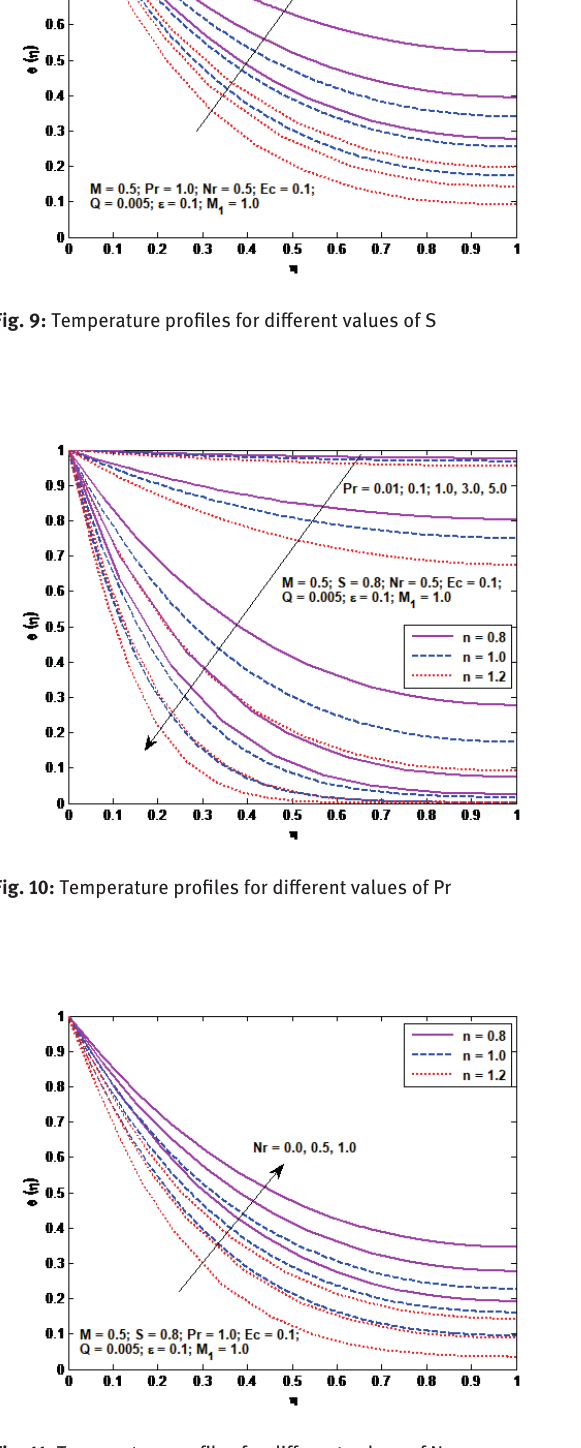
Fig. 8: Horizontal velocity profiles for different values of S